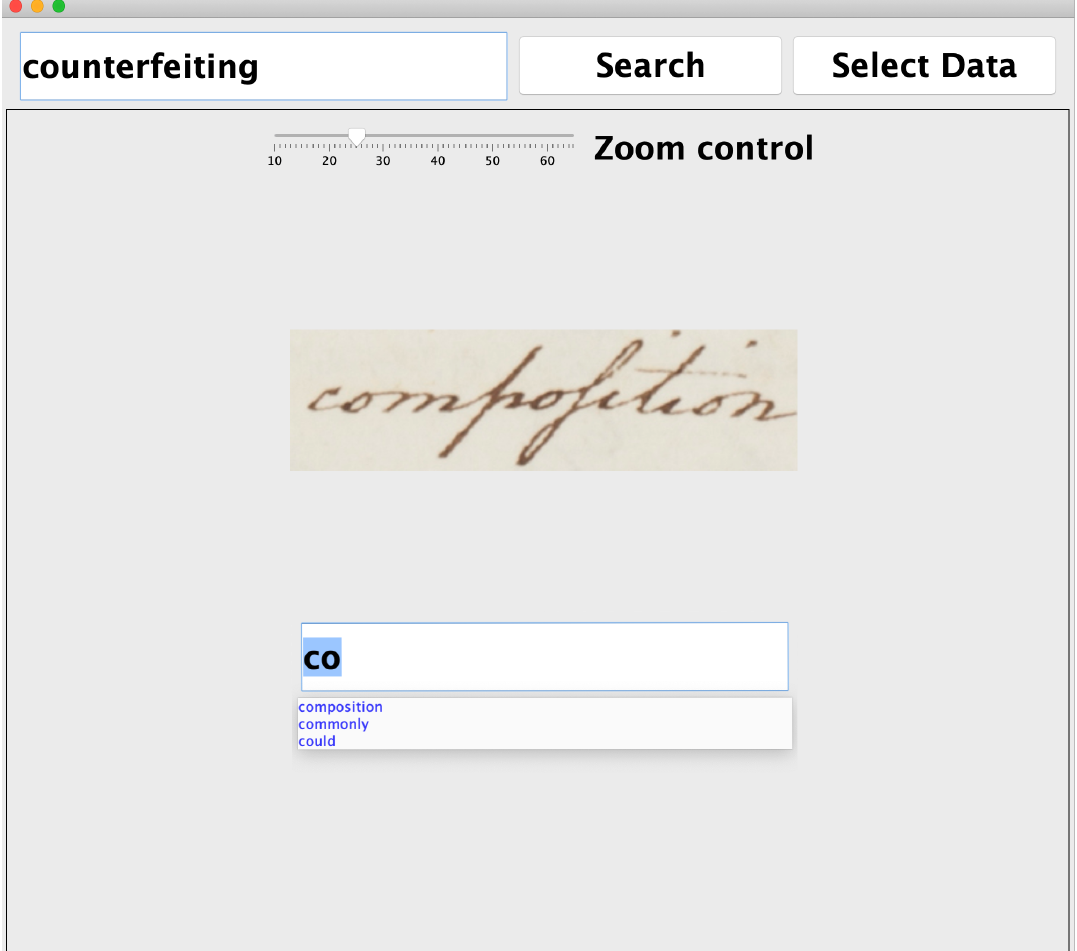
Figure 4. Graphic user interface (GUI) designed for validating the output of the KWS system. The keyword spotted by the system is shown in the text box placed in the top left corner. The button “Search” starts the word spotting. The button “Select Data” allows to select the data set DS . The slider regulates the dimension of the image. The text box located on the bottom is used for typing the transcription of the word image. The text box supports the auto-completion